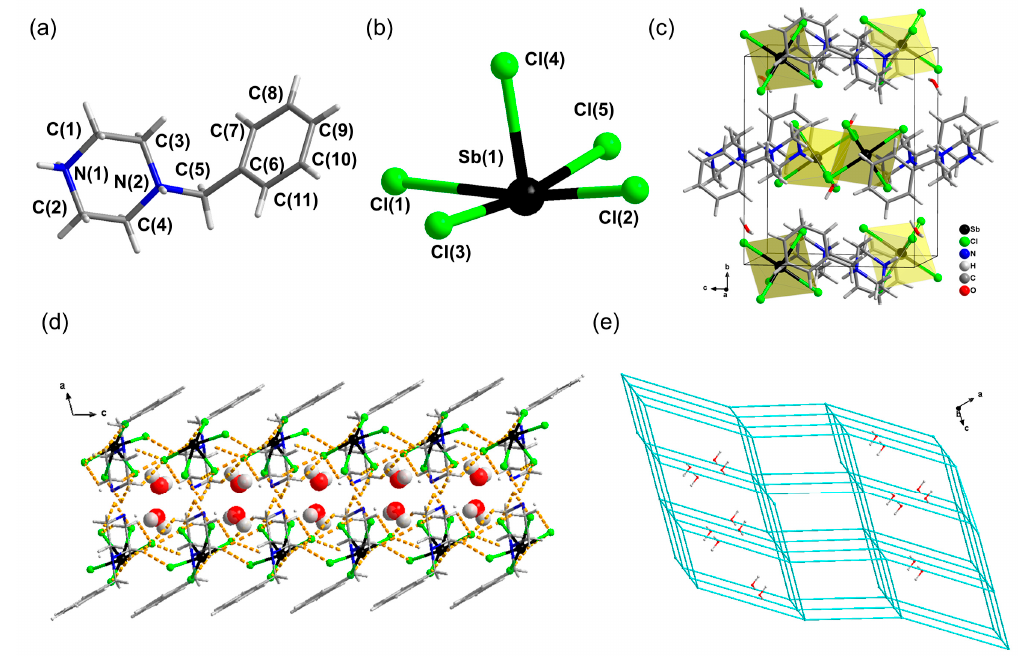
Figure 1. Structural diagrams for the title crystal [H 2 BPZ][SbCl 5 ] · H 2 O. A [H 2 BPZ] 2+ cation ( a ) and a [SbCl 5 ] 2 − anion ( b ) in [H 2 BPZ][SbCl 5 ] · H 2 O. ( c ) Unit-cell-packing diagram viewed down the a -axis. ( d ) A supramolecular layer in [H 2 BPZ][SbCl 5 ] · H 2 O viewed along the b -axis in which lattice water molecules are located; water molecules are in CPK mode; hydrogen bonds with water molecules are not shown for clarity. ( e ) Topological net of pcu type for anions arrangement in [H 2 BPZ][SbCl 5 ] · H 2 O where the lattice water molecules are shown. Table 1. Select bond lengths (Å) and bond angles ( ◦ ) for [H 2 BPZ][SbCl 5 ] · H 2 O at 293 K.